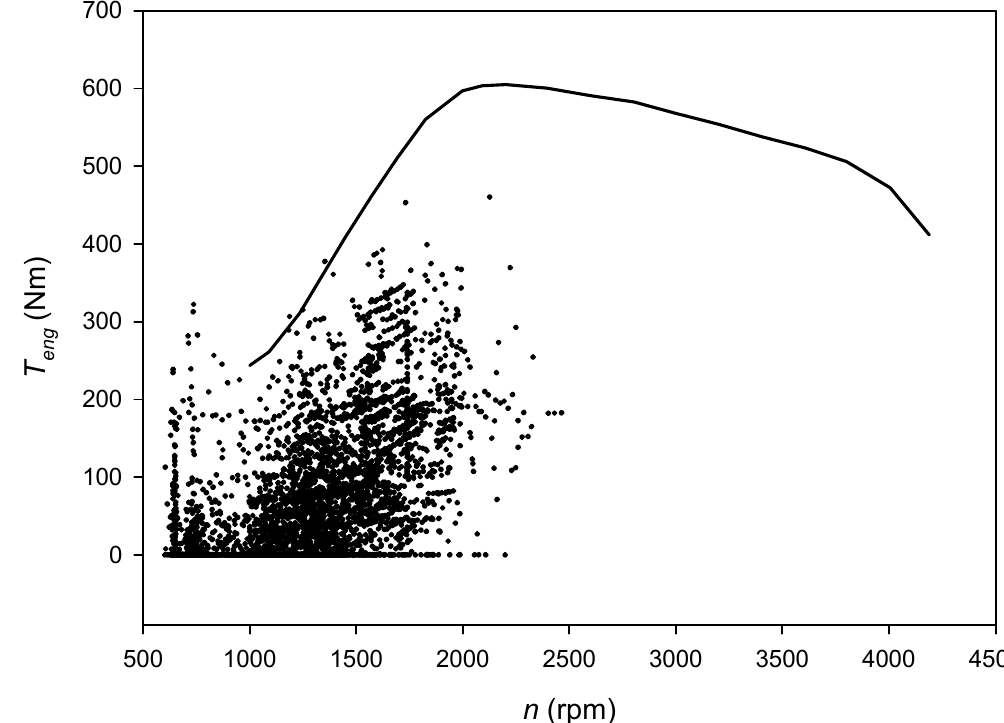
Figure 3. Engine operating points over the RDE test.